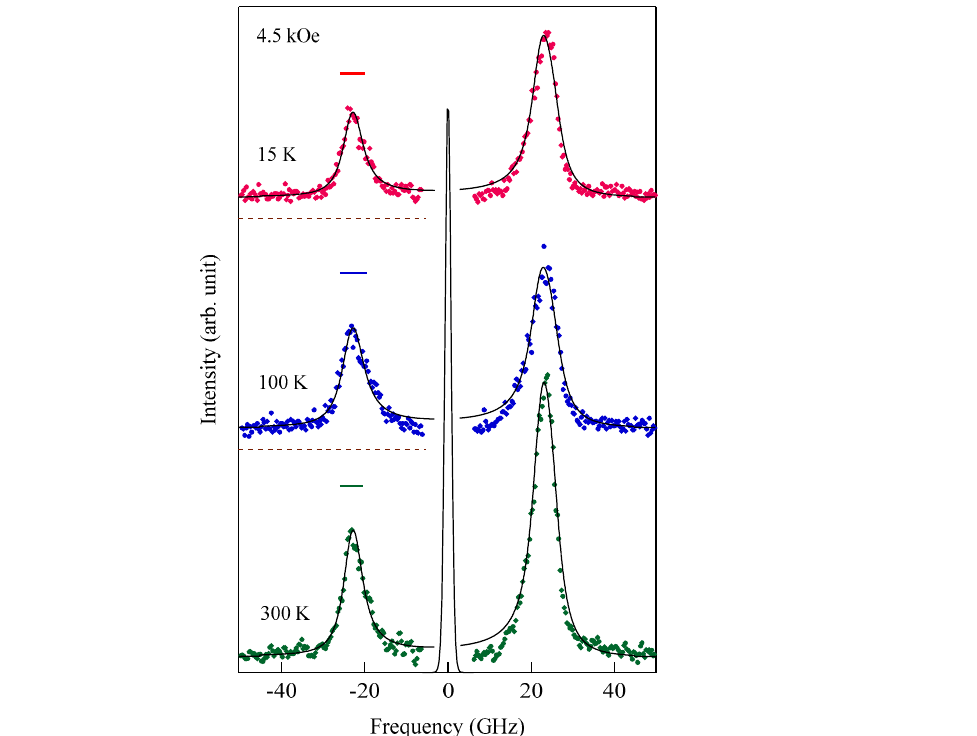
Figure 38. Temperature development of the SPM peak frequencies (Bulk-type ( ○ ) and DE-type ( ■ ) modes) and the damping constant ( • ) at 4.5 kOe. The SPM peak frequencies are determined from